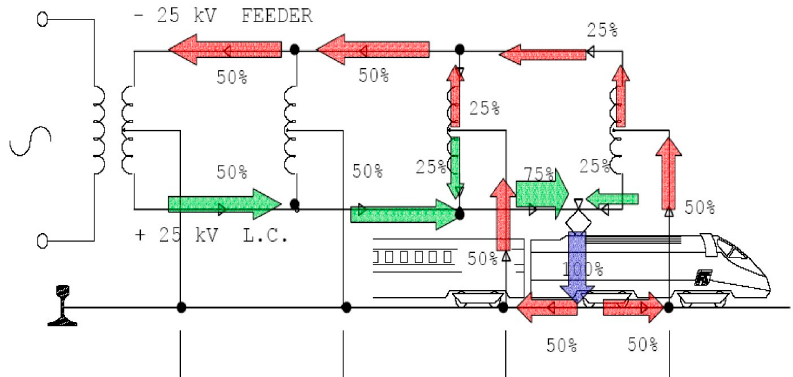
Figure 1. Power flow in an ideal 2 × 25 kV autotransformer system.